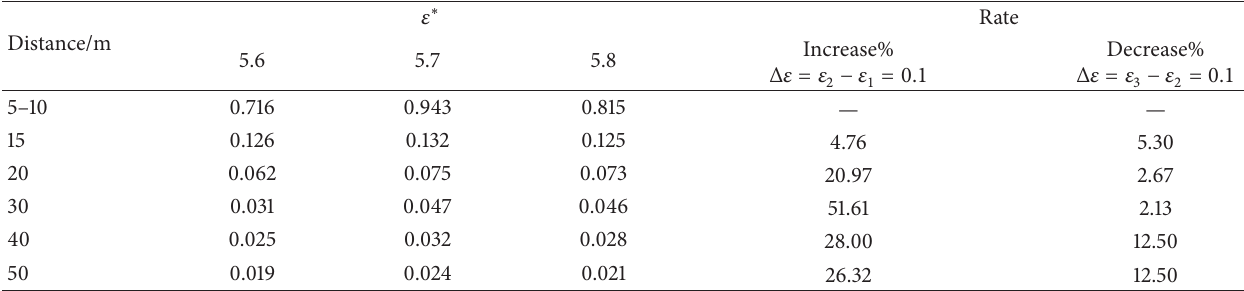
Table 2: Peak overpressure with 𝜀 at the fixed distance.